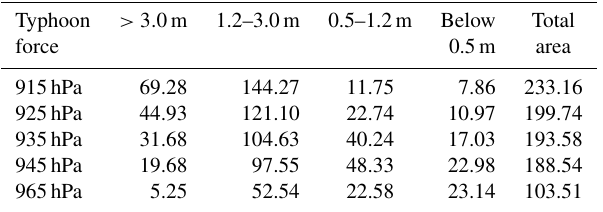
Table 6. Extension of inundated areas associated with different ty- phoon intensity scenarios for different water level thresholds (unit – km 2